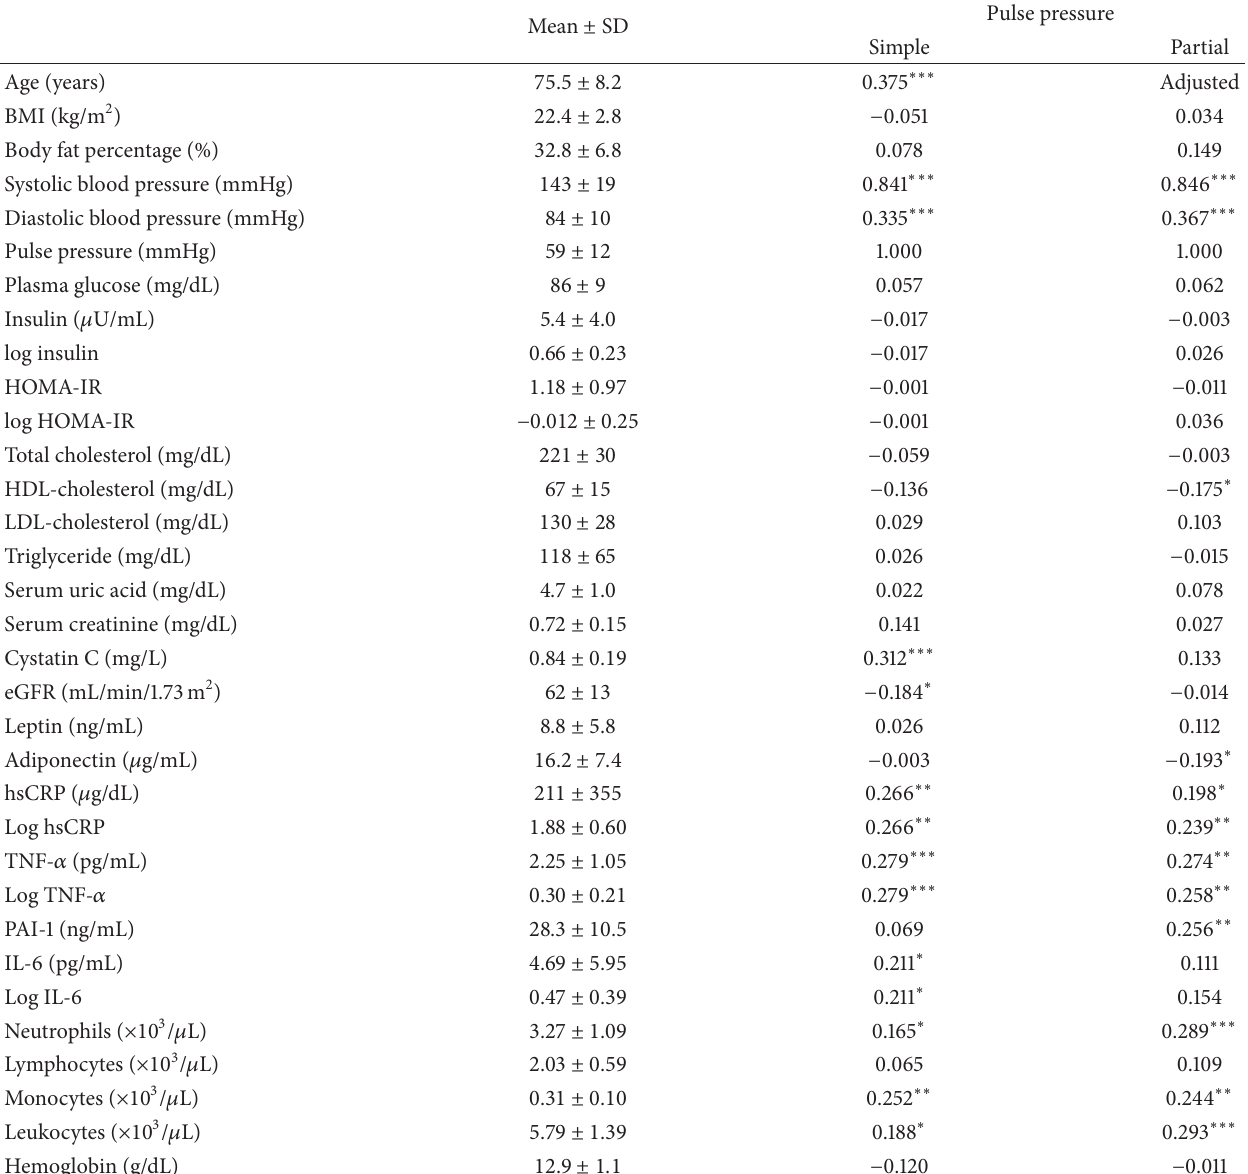
Table 1: Anthropometric and biochemical characteristics of 150 free-living elderly women studied and correlation coefficients of brachial pulse